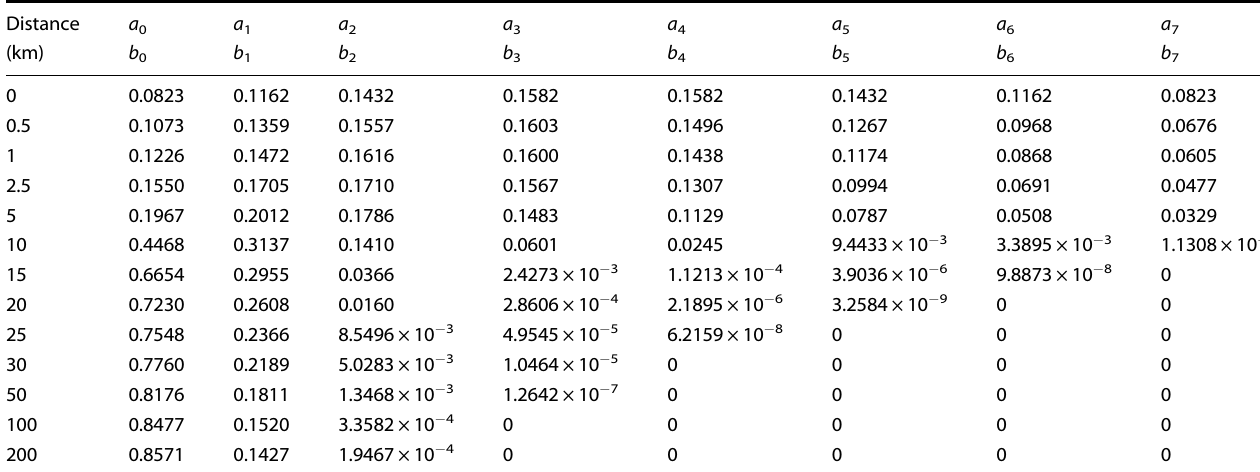
Table 2. The coef fi cients of the optimised states with n max ¼ 7 photons.